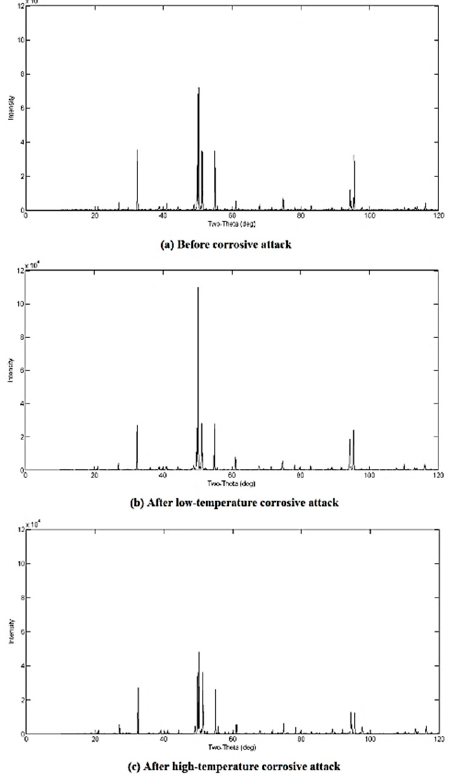
Figure A23. Qualitative XRD analysis of the surface of CS-A-Sn ( a ) before corrosive attack, ( b ) after low-, and ( c ) high-temperature corrosive attack.